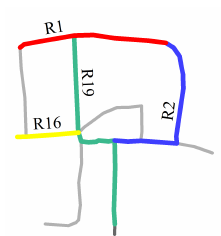
Figure 8. Main roads (in color) with different curves.